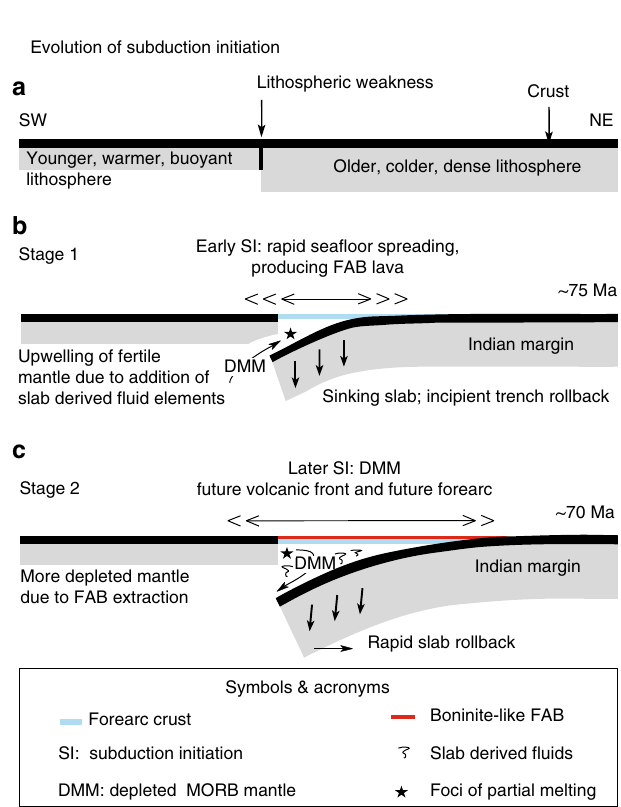
Fig. 6 Conceptual model of intra-oceanic subduction initiation. The cartoon shows general evolution of SI (modi fi ed after Metcalf and Shervais 71